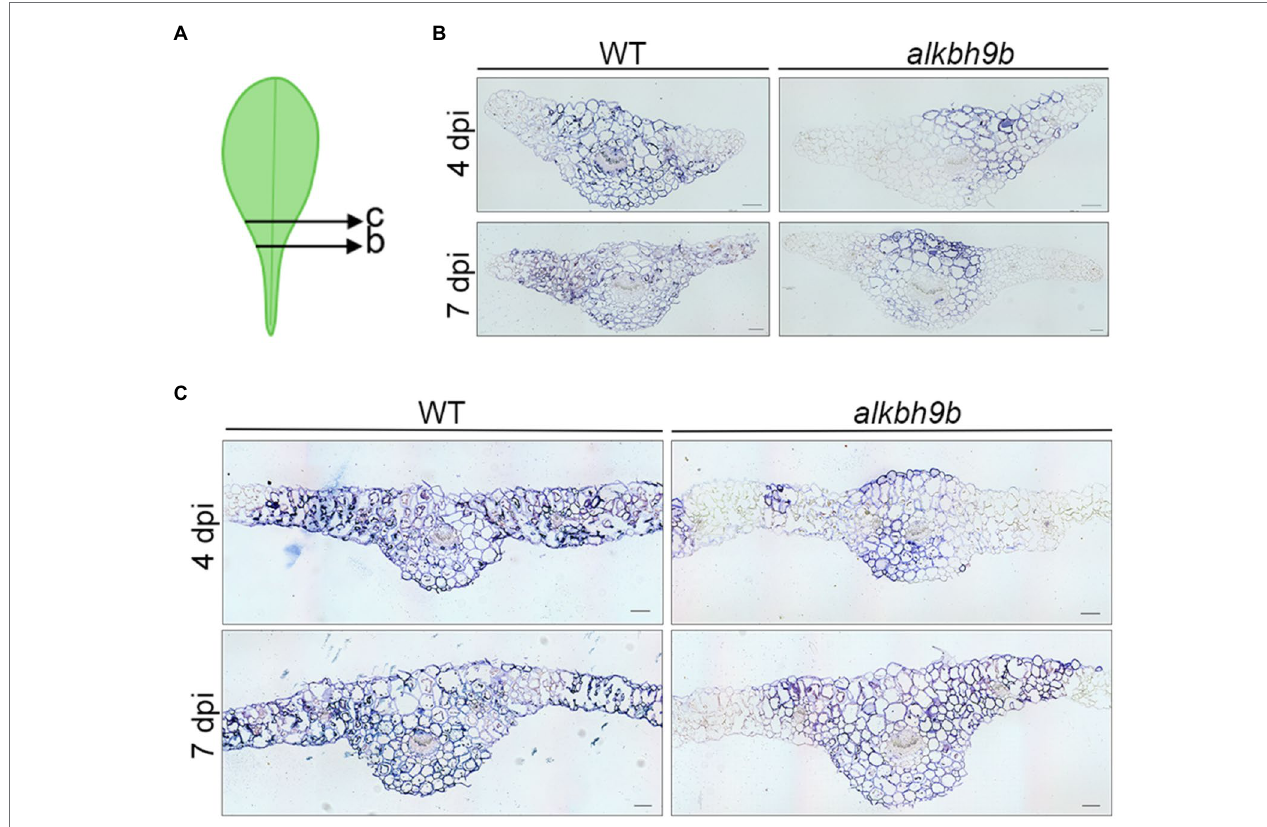
FIGURE 5 | AMV fails to invade the vascular tissue of alkbh9b plants. (A) Picture showing the approximate sections used for in situ hybridization assay. (B,C) In situ hybridization of the petioles (B) and blades (C) of AMV-inoculated leaves at 4 and 7 dpi (indicated in each panel) from WT and alkbh9b plants. Scale bars correspond to 100 μ m.